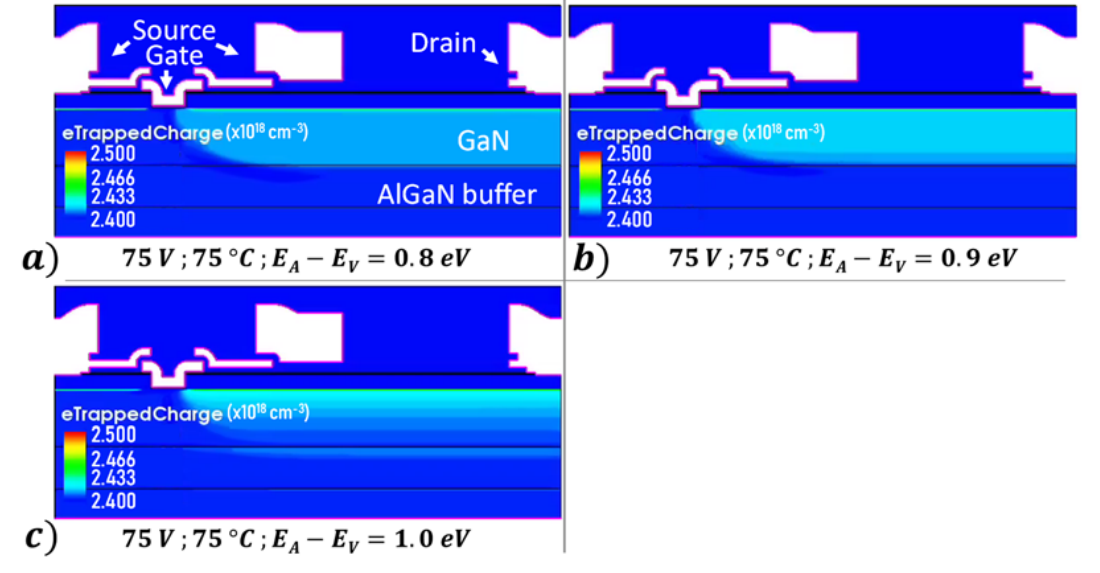
Figure 10. TCAD acceptor trap ionization mapping with the lower tick parameter of the colored scale equal to the concentration of the donor traps at V = 75 V; T = 75 ◦ C; [A] − [D] of 1 × 10 17 cm − 3 ( a ) E A -E V = 0.8 eV; σ = 3 × 10 − 18 cm 2 ( b ) E A -E V = 0.9 eV; σ = 1 × 10 − 16 cm 2 ( c ) E A -E V = 1.0 eV; σ = 5 × 10 − 15 cm 2